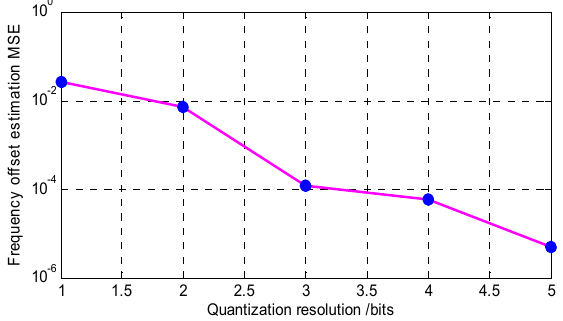
Figure 7. Mean-square error of frequency offset estimation.